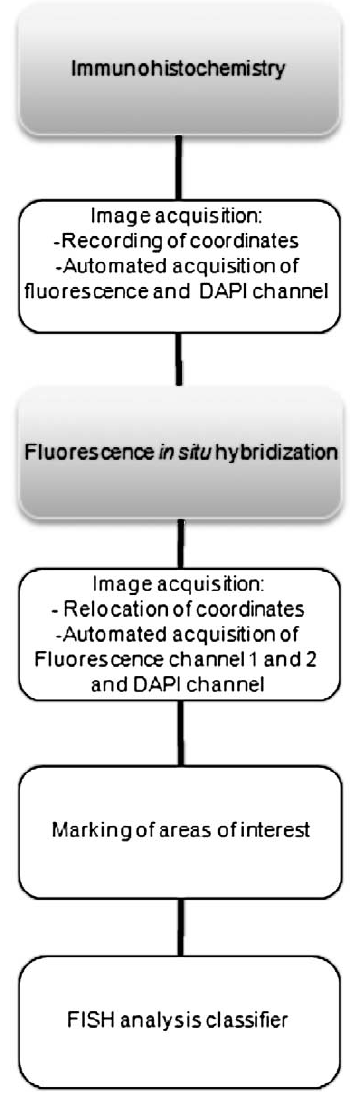
Fig. 1. Schematic presentation showing the workflow of automated and subsequent analysis of gene amplification and protein expres- sion in paraffin-embedded tumour tissue. The boxes highlighted in grey symbolize bench work steps while the white boxes represent microscope and analyses